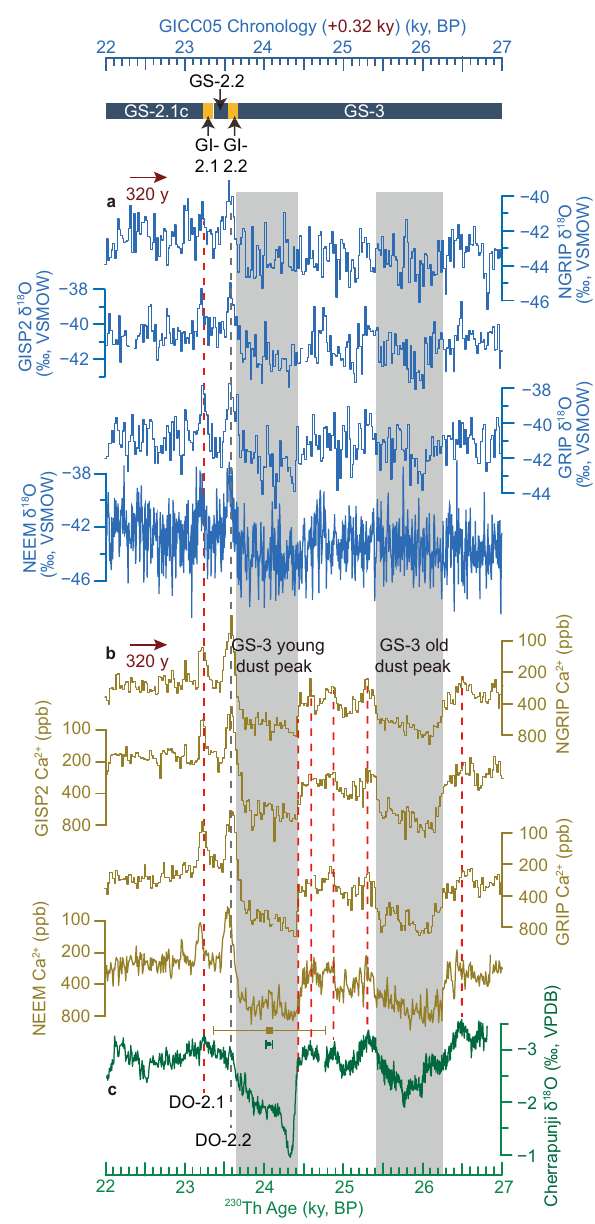
Fig. 3 | Correlation between Greenland ice-core δ 18 O/[Ca 2+ ] records and the Cherrapunji δ 18 O record. a Greenland ice-core δ 18 O records: NGRIP, GISP2, GRIP, and NEEM records (Supplementary Note 1.5). b Greenland ice-core [Ca 2+ ] records (notetheinvertedlogarithmic[Ca 2+ ]y-axis,assameasinref.2):NGRIP,GISP2,GRIP, andNEEMrecords(SupplementaryNote1.5). c Cherrapunjispeleothem δ 18 Orecord (this study). Greenland ice-core records are shown on the GICC05 chronology (Supplementary Note 1.5), which is shifted by +320 years via tuning the Greenland [Ca 2+ ]time-seriestotheCherrapunji δ 18 Orecord(seemaintext).Verticalreddashed lines depict the tie points between the ice-core and speleothem records (Supple- mentary Table 3). The leftmost two dashed lines correspond to Greenland Inter- stadial (GI)-2.1 and GI-2.2 peaks in Greenland 2 and their counterparts in the Asian summer monsoon regime (Dansgaard/Oeschger (DO)-2.1 and DO-2.2 peaks). Ver- tical gray bars depict the Greenland Stadial (GS)-3 dust peaks 94 . Error bars show uncertainty (2 σ ) of the 230 Th chronology of the Cherrapunji record (green) in comparison to the possible age bias of the GICC05 timescale 2